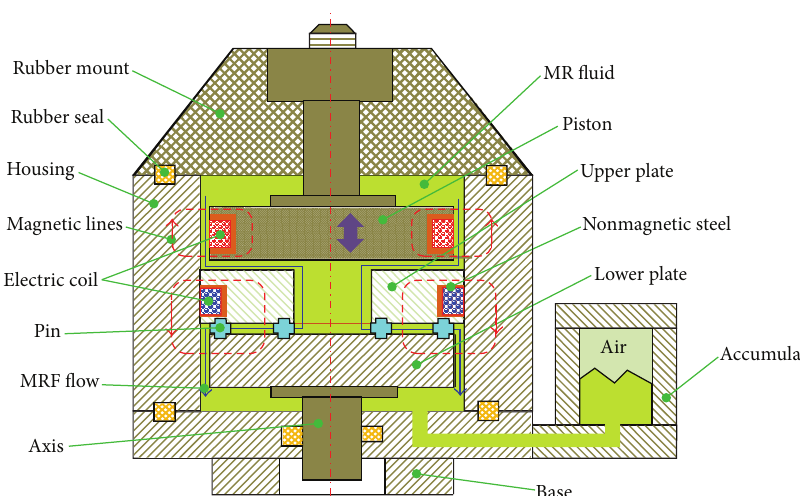
Figure 17: Configuration of high loaded MR damper-mount.